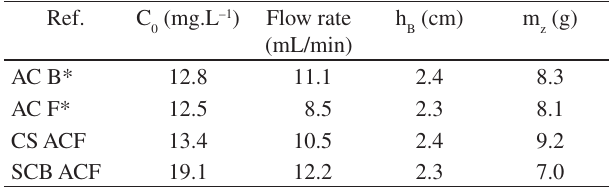
Table 1. Experimental conditions for adsorption dynamic of [D-Leucine 1 ] MCYST-LR on fixed-bed ACF. Ref.